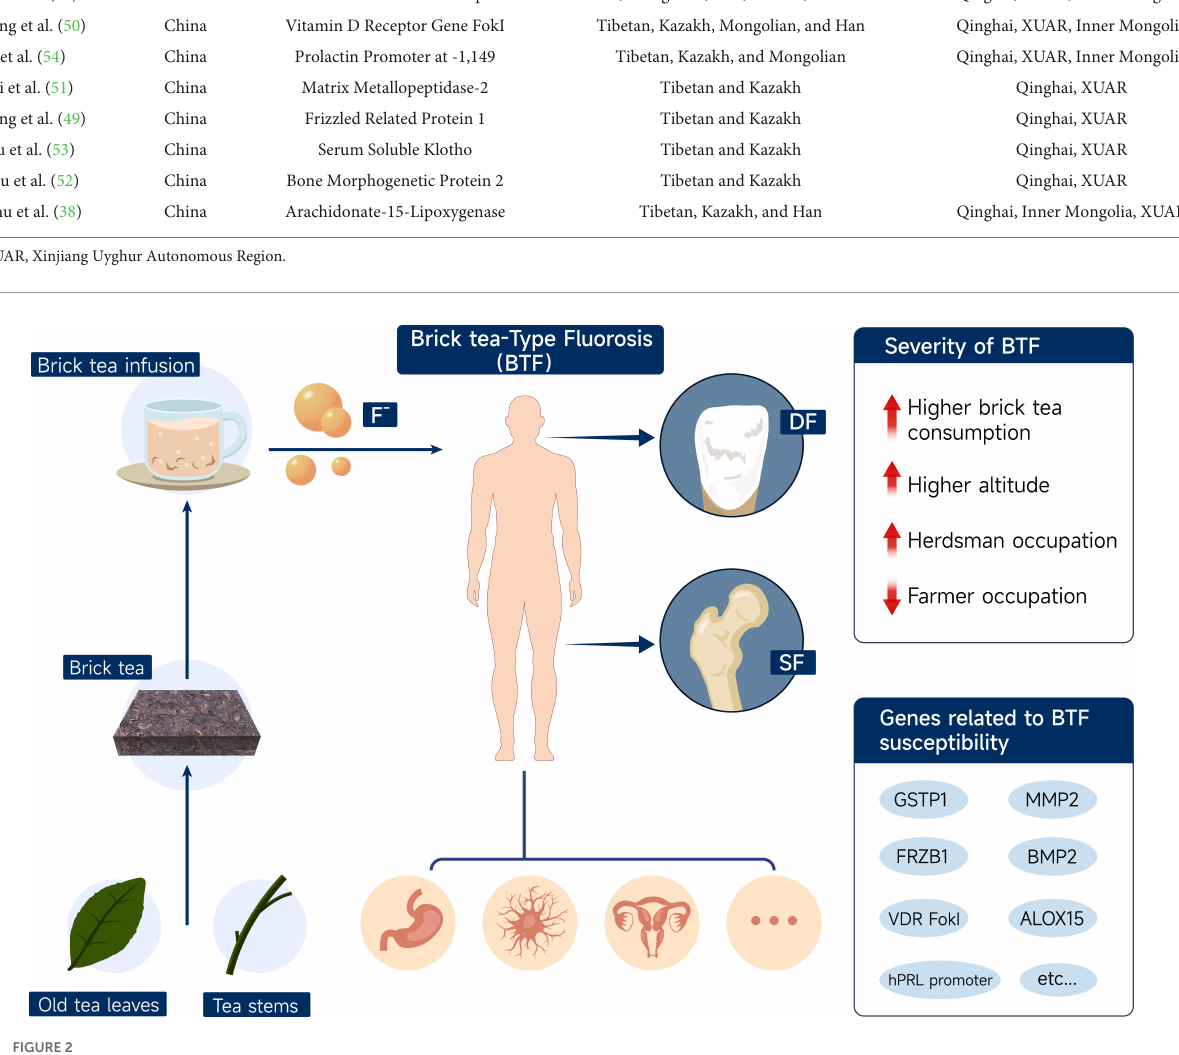
disease. Patients with SF who experience pain should be given an appropriate dose of non-steroidal analgesics. Those with skeletal deformities should have local fixed or orthopedic surgery to prevent deformity